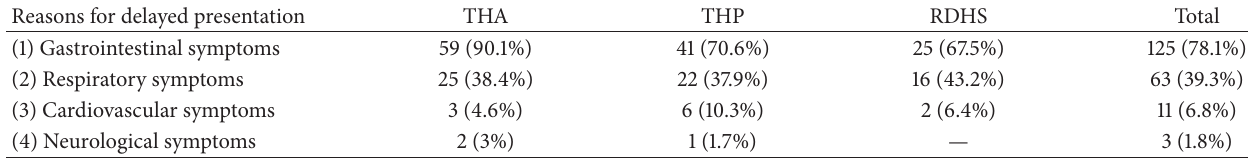
Table 3: Clinical manifestations of plant poisoning among children in rural Sri